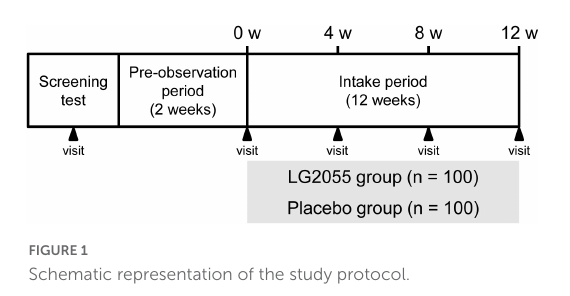
FIGURE1 Schematic representation of the study protocol.